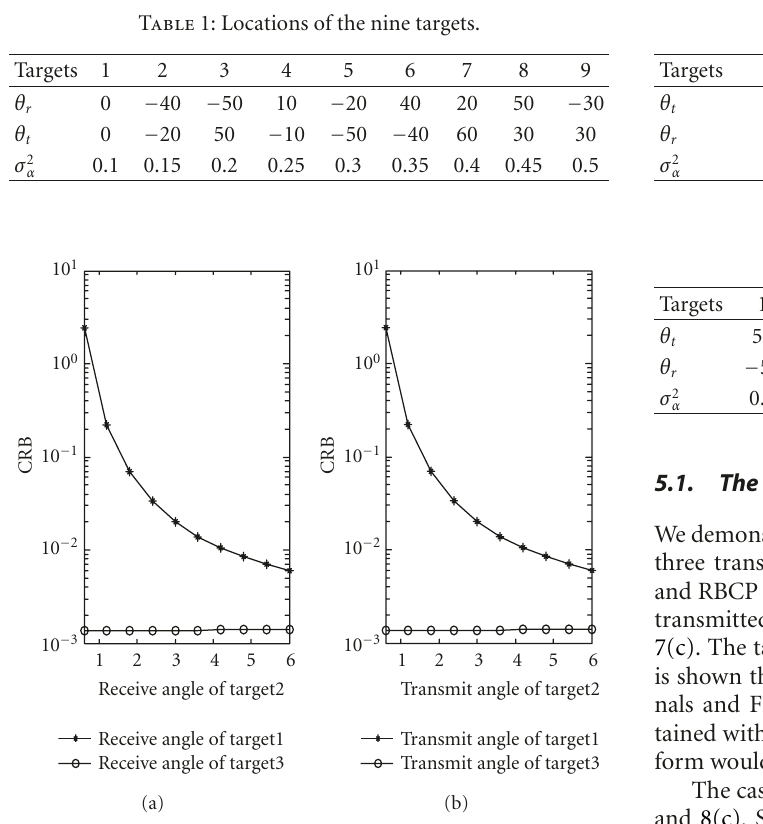
= 0 . 7, σ 2 = 0 . 75, σ 2 = 0 . 8 SNR = 8dB. α 1 α 2 α 3